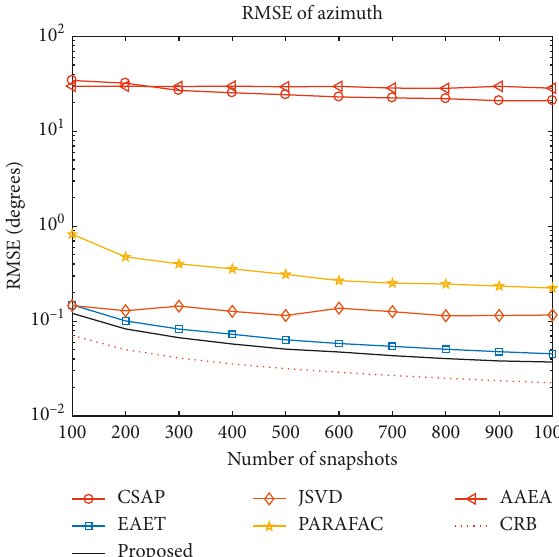
Figure 4: The RMSE of azimuth estimation vs. snapshots with 3, (cid:28) K 3, M 7, and SNR (cid:28) (cid:28)